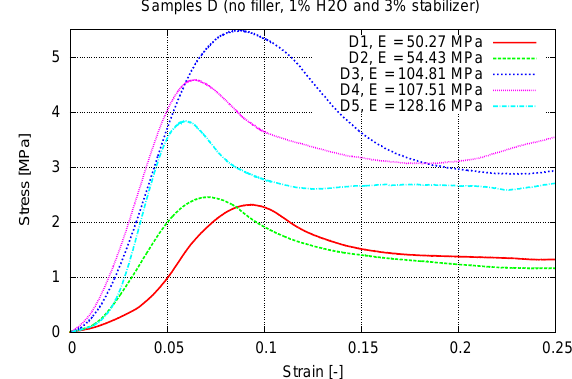
Figure 4. Stress-strain curves of Calcium carbonate filler